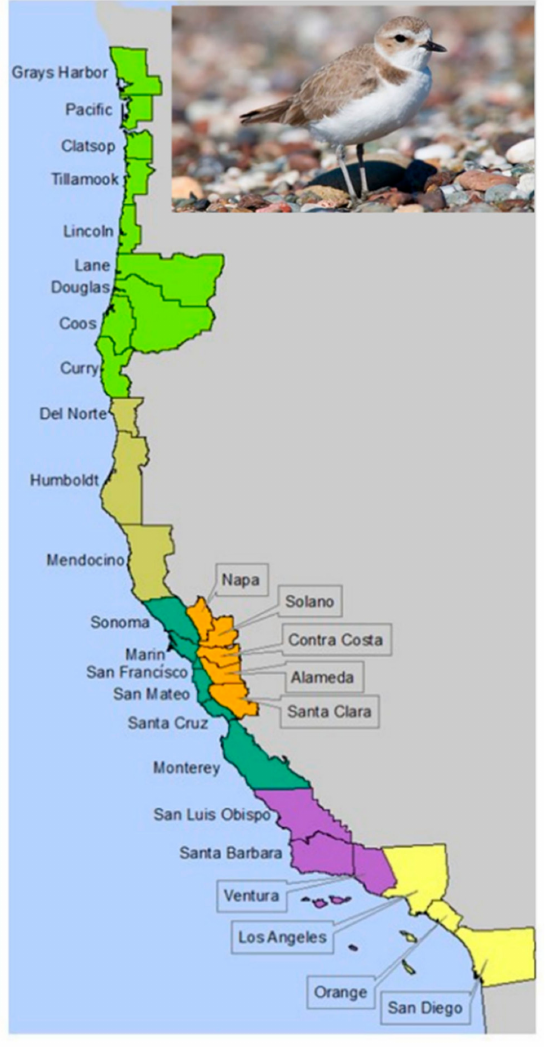
Figure 1. Western snowy plover recovery units (colors) and counties (polygons) along the west coast, US. The six recovery units include: (1) Washington and Oregon (lime green); (2) northern California (Del Norte, Humboldt, and Mendocino counties; tan); (3) San Francisco Bay (locations in Napa, Alameda, Santa Clara, and San Mateo counties; orange); (4) Monterey Bay (including coastal areas along Monterey, Santa Cruz, San Mateo, San Francisco, Marin and Sonoma counties; dark green); (5) San Luis Obispo, Santa Barbara, and Ventura counties (purple); and (6) Los Angeles, Orange, and San Diego counties (yellow) (photo source: Public domain, US Fish and Wildlife Service, Oregon Field Office, https://www.fws.gov/oregonfwo/articles.cfm?id=149489510 (accessed on 21 February